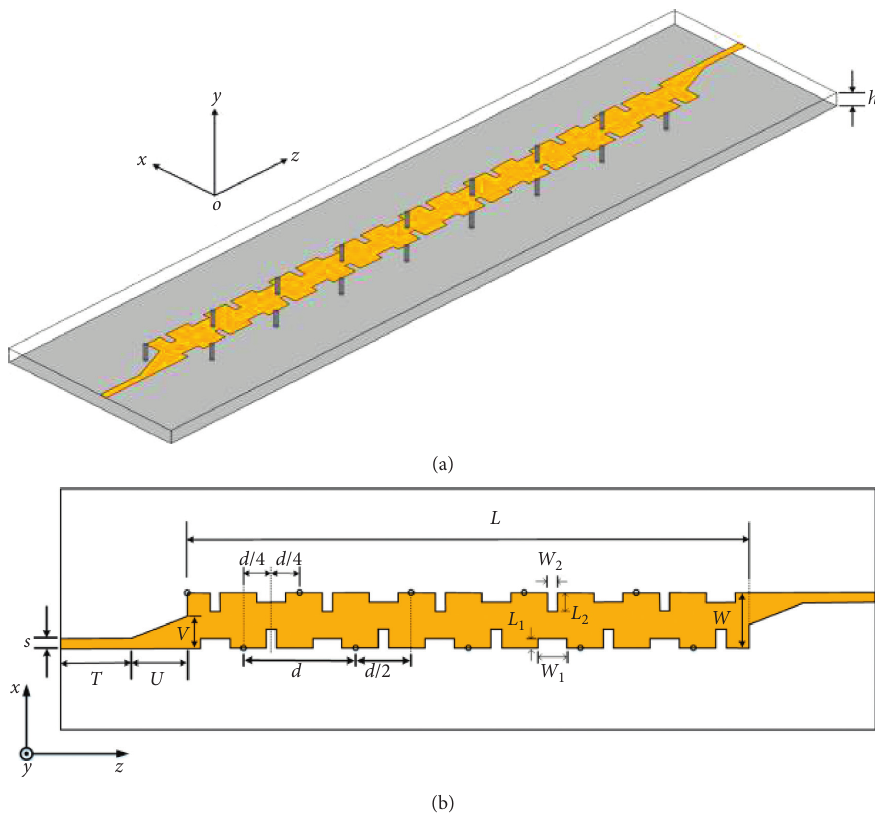
Figure 1: The proposed periodic microstrip leaky wave antenna with double-sided shorting pins. (a) 3D view. (b) Top view.